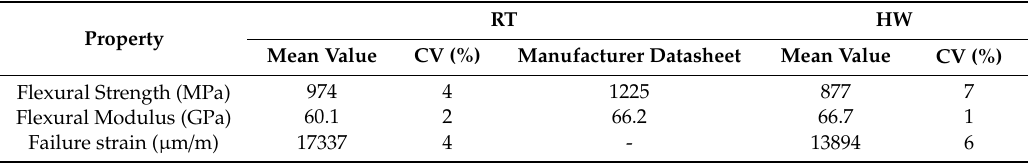
Table 7. E ff ect of hot-wet storage aging on the mechanical properties derived from static flexure tests.